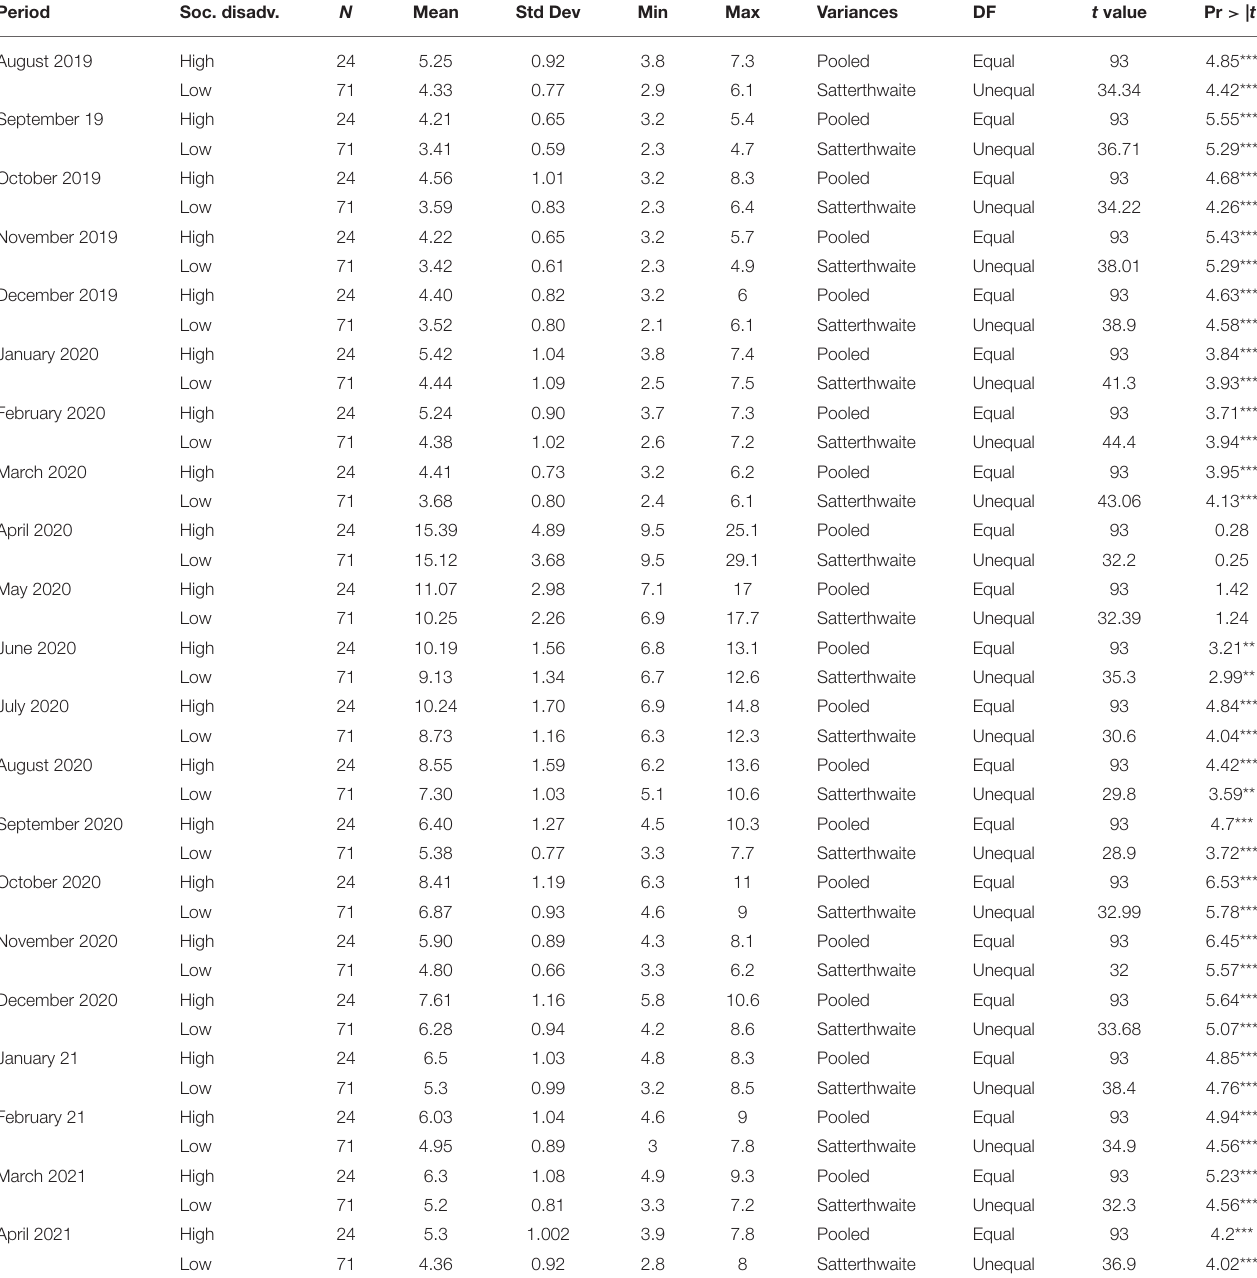
TABLE 2 | T -test results of unemployment rates between communities with high and low disadvantage, August 2019–April 2021. Period Soc.